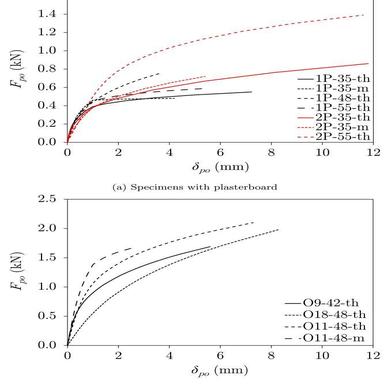
Model fitting of the average key properties presented in Table 10 and comparisons between the load-slip behaviour of a screw connector per shear plane when connected to (a) plasterboard and (b) OSB.